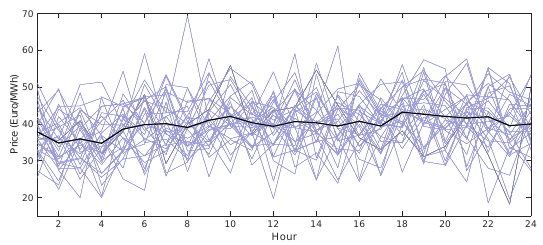
Figure 3. Scenarios and mean of the day-ahead market prices.